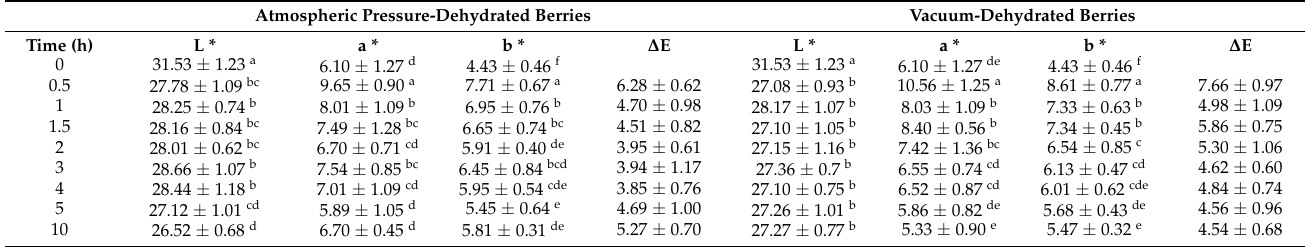
L*, a*, and b* are the color parameters representing the lightness, redness, and yellowness, respectively. Means in one column with